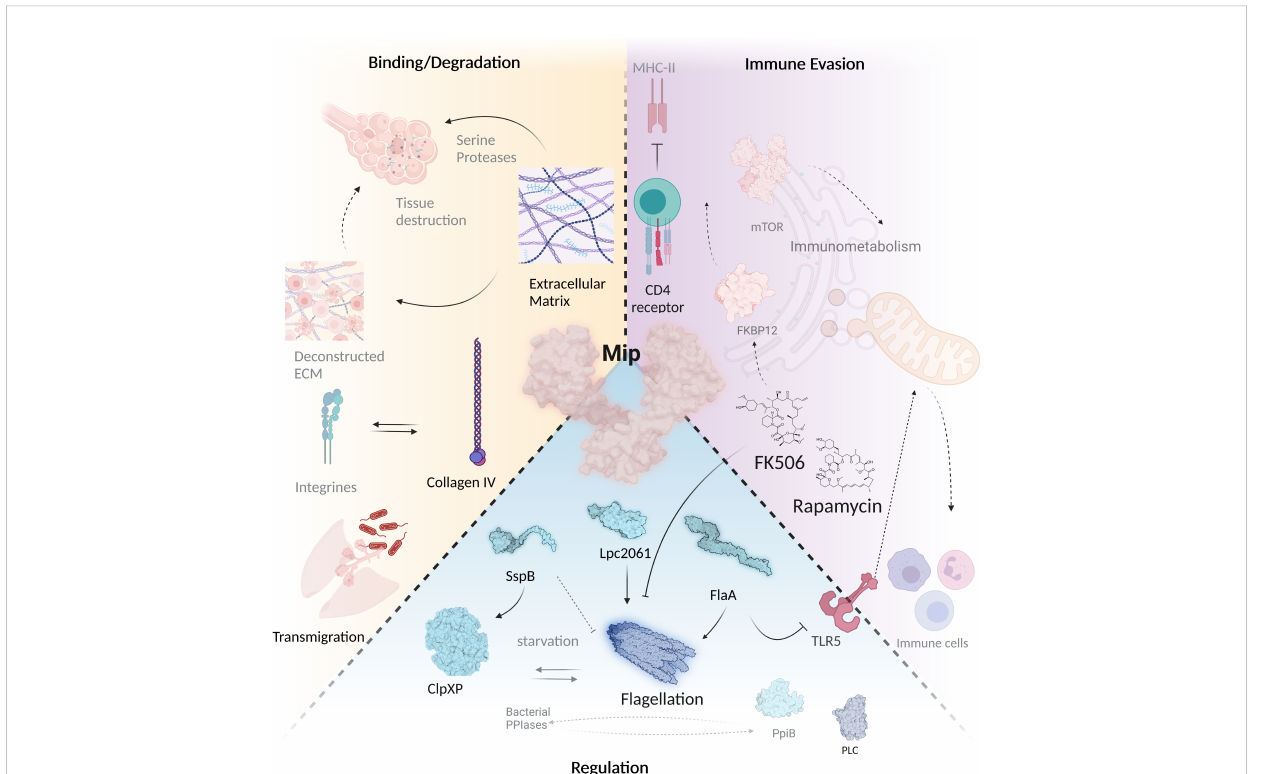
FIGURE 4 Mip mediates virulence regulation, host tissue degradation and immune evasion. The virulence factor Mip interferes with a wide variety of infection- associated processes via different interaction partners. During Legionnaires ’ disease, it is important that bacteria migrate through different tissue barriers. This is facilitated by binding of Mip to collagen IV, which is subsequently degraded by a serine protease. Mip binds to SspB, Lpc2061 and FlaA, and promotes fl agellation by its PPIase domain that can be inhibited by FK506 and rapamycin. Binding of FK506 and rapamycin to PPIases modulates immunometabolism and interferes with bacterial immune evasion. Mip regulates stress response and infectivity in bacteria together with other PPIases and promotes Phospholipase C (PLC) activity (created with